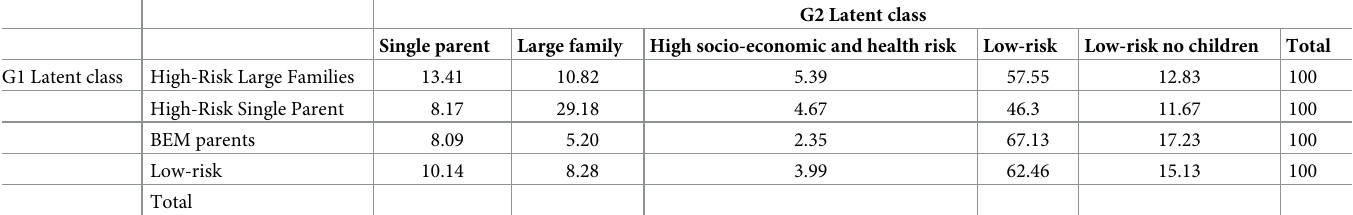
Table 6. Transition probability matrix G1 ! G2 latent